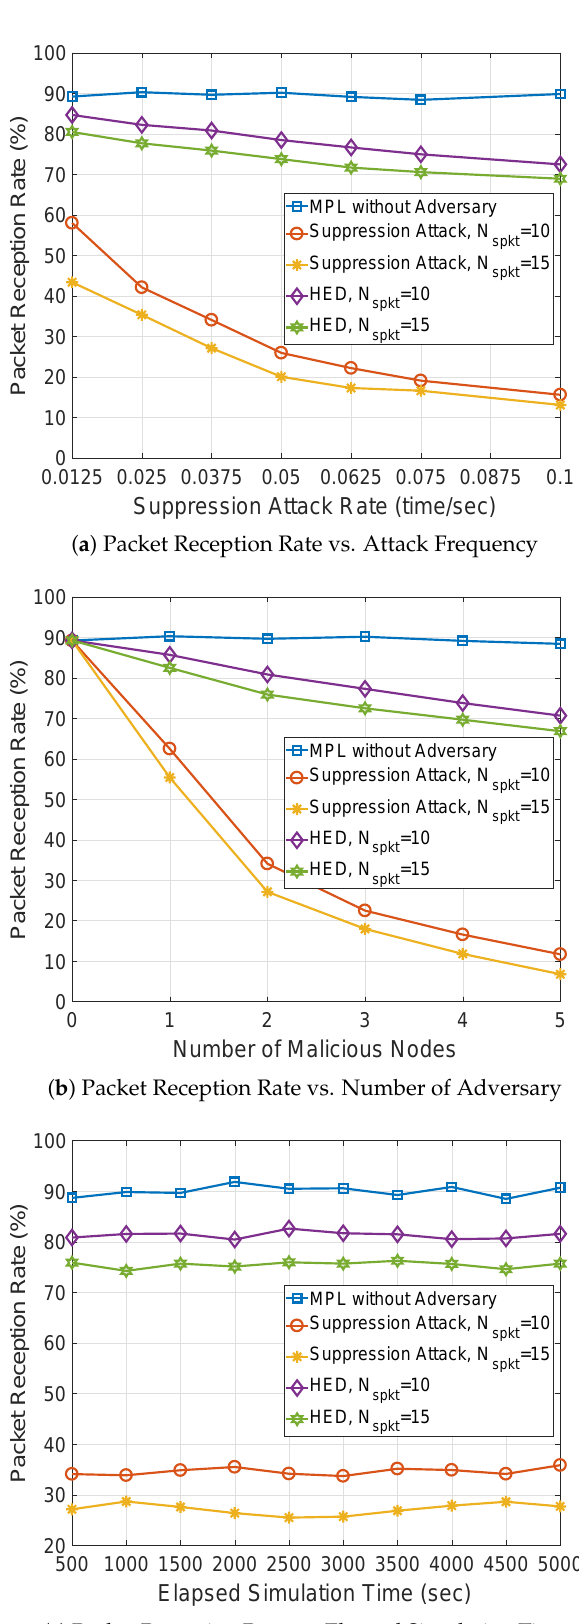
Figure 8. The packet reception rate (PRR) against suppression attack rate, number of malicious nodes, and elapsed simulation